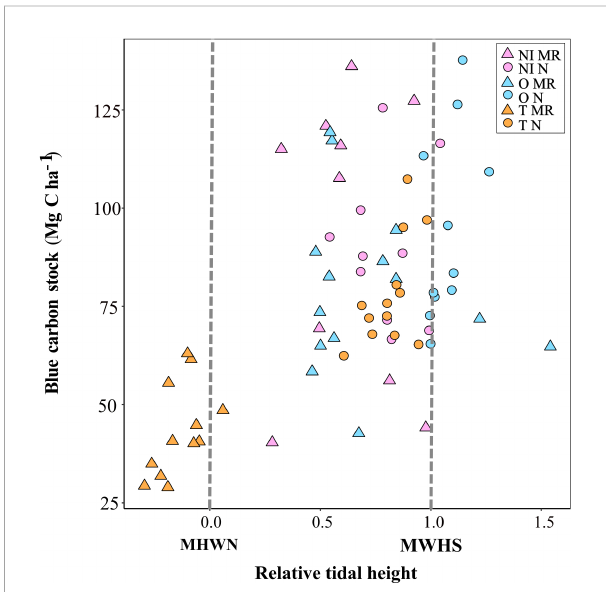
FIGURE 3 Carbon stock against relative tidal height for managed realigned (MR; triangle) and natural (N; circle) sites [NI, Northey Island; O, Orplands; T, Tollesbury]. Saltmarshes generally occur between mean